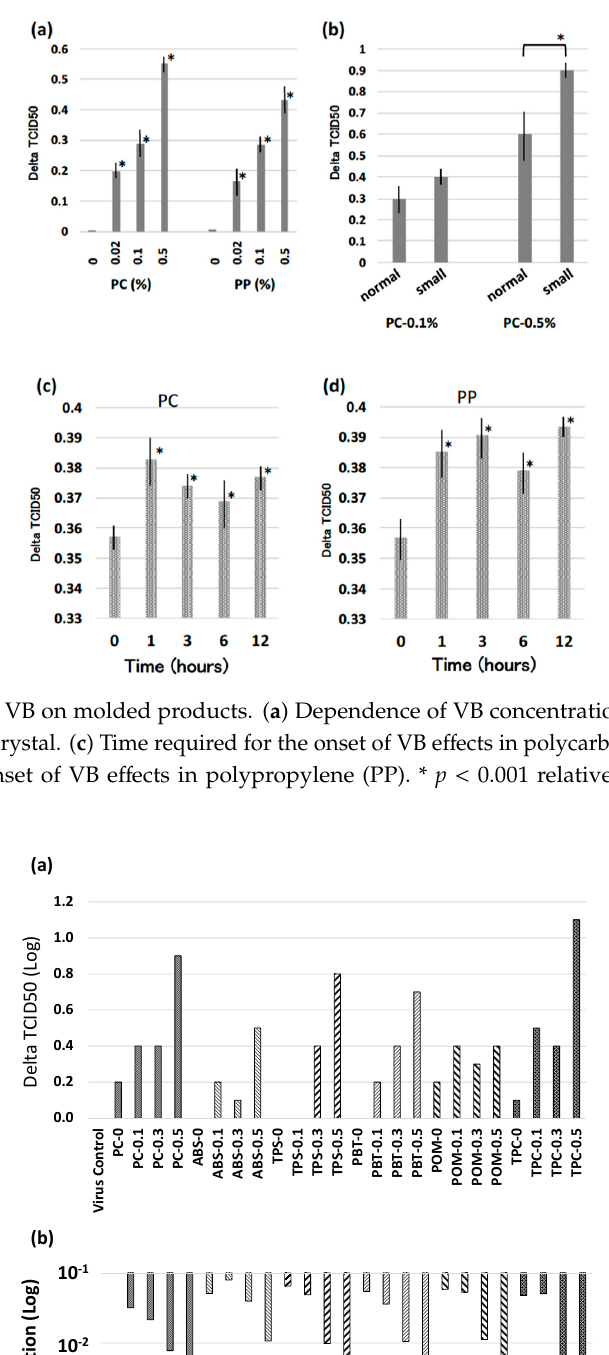
the reproducibility, with five additional materials (ABS, TPS, PBT, POM, and TPC) for examination